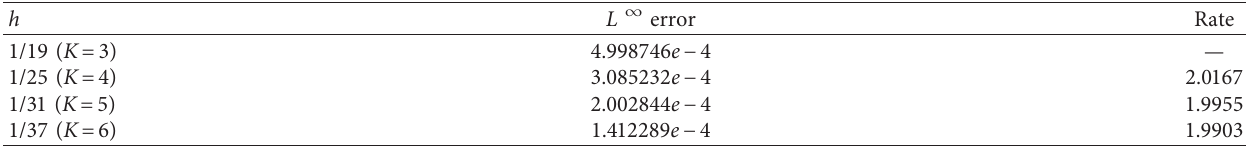
Table 1: Convergence rate of Algorithm 1 for h at t � 0.4.